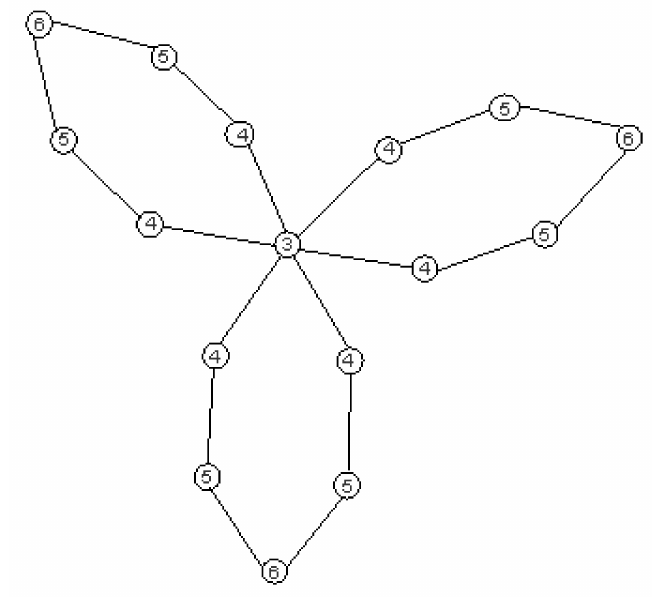
Figure 3. Dutch windmill graph D 3